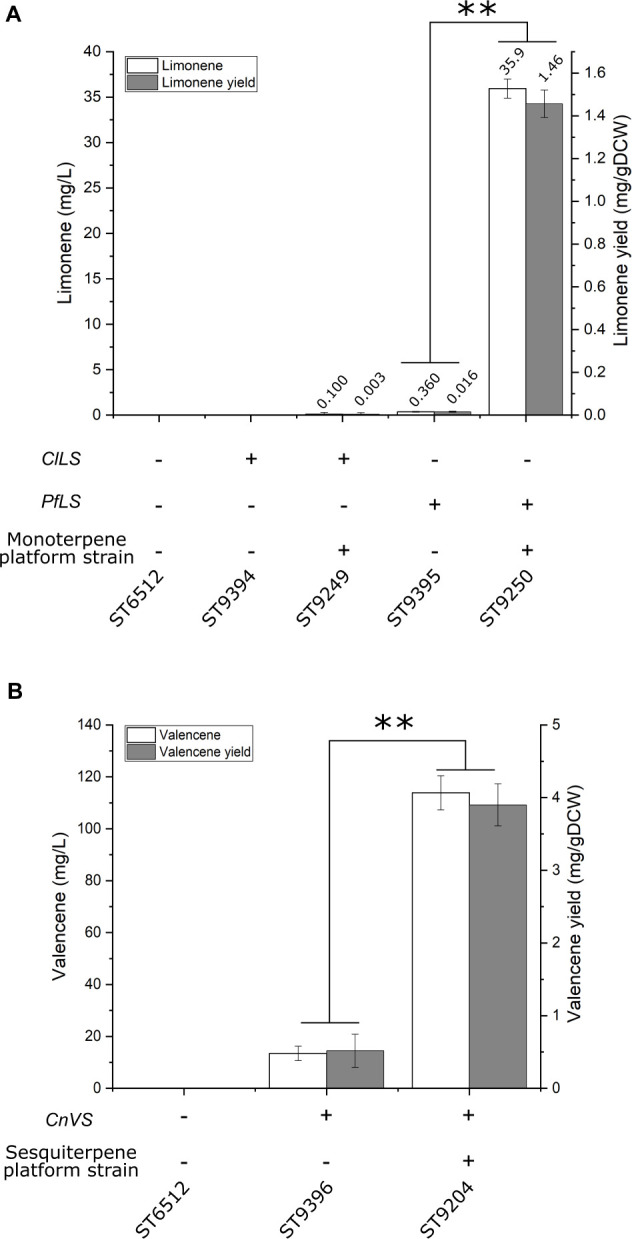
Limonene and valencene production by platform strains. (A) Limonene production in base and monoterpene platform strain. ClLS, C. lemon limonene synthase; PfLS, P. frutescens limonene synthase. The monoterpene platform strain contains the following gene overexpressions of HMG, ERG12, ACL, SeACS, IDI, ERG20F88W–N119W, and swapping the native squalene promoter (pERG11_SQS). (B) Valencene production in base and sesquiterpene platform strain. CnVS, C. nootkatensis valencene synthase. The sesquiterpene platform strain contains the same modifications as the monoterpene platform strain, with the exception of ERG20 instead of ERG20F88W–N119W. Standard deviations from the values of three biological replicates are represented by error bars. Double asterisks marks significant change (student’s t-test, two-tailed, p < 0.001).